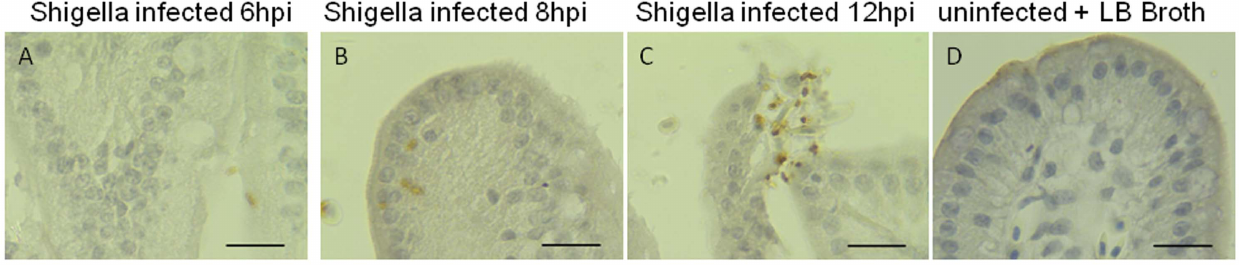
Figure 4. Immunohistochemistry of the jejunum of one-day-old SPF chickens infected with the Shigella strain ZD02 via ligated intestinal loop. Bacterial invasion (brown staining) was noticed in the epithelial cells 6 h (A) and 8 h (B) post-inoculation. The intestinal villus detached and the bacteria (brown staining) were released from the lysed epithelial cells (C). Intestinal villus of uninfected chicken was shown as control (D). Scale bars=20 m